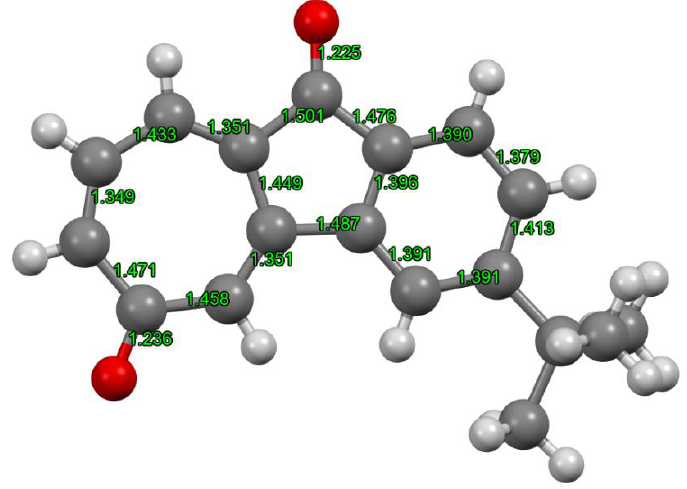
Figure 4. X-ray structure and selected bond lengths of 2a (CCDC 1990090); recrystallized from methanol. Space group: P 2 1 /c, crystal system: monoclinic, a [Å ] = 10.9399(6), b [Å ] = 18.0026(8), c [Å ] = 6.9786(4), α [°] = 90, β [°] = 105.291(6), γ [°] = 90, V [Å 3 ] = 1325.76(13), Z value = 4, D calc [g/cm 3 ] = 1.324, μ (MoKa) [mm − 1 ] 0.085, R 1 (I > 2 .00σ) 0.0518, R 1 (all reflections) 0.0733, w R 2 (all reflections) 0.1326.